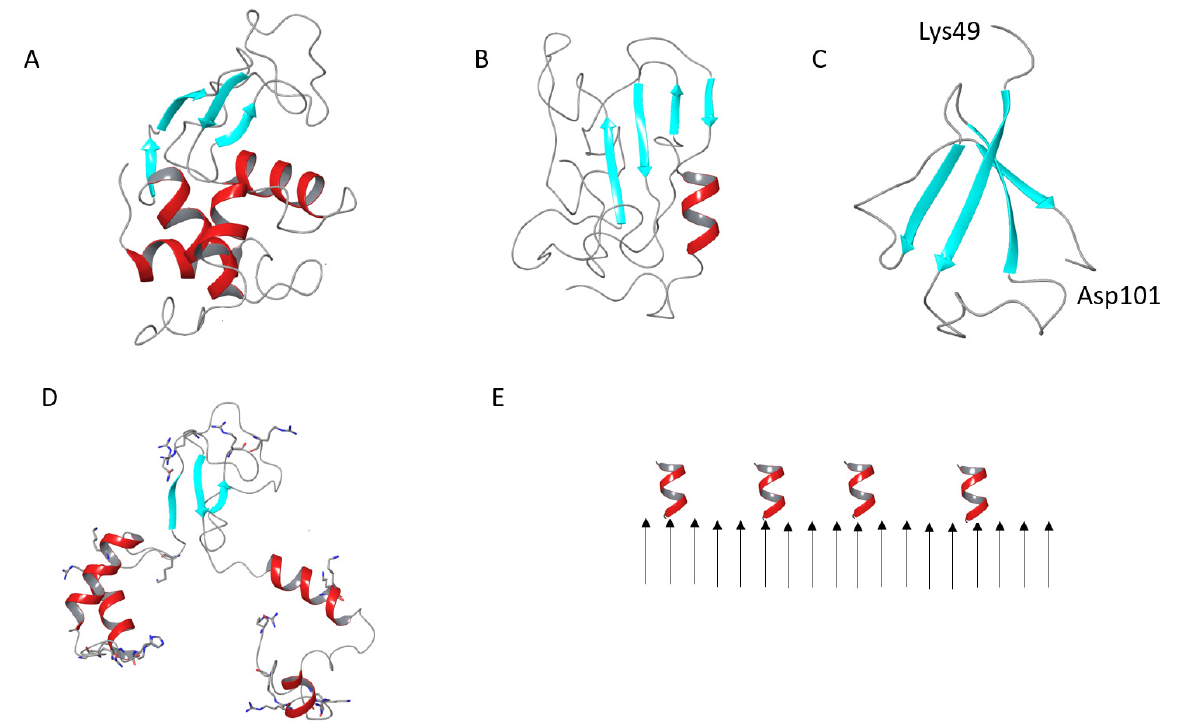
Figure 9. Cartoon representation of the native HEWL ( A ), a model of the β -structure-rich conformer of denatured HEWL ( B ), a model of the β -structure-rich conformer of amyloidogenic HEWL fragment ( C ), a model of the partially desaturated HEWL globule, positively charged residues are shown in sticks ( D ), a scheme of the deposition of helices on the HEWL fibril surface ( E ).